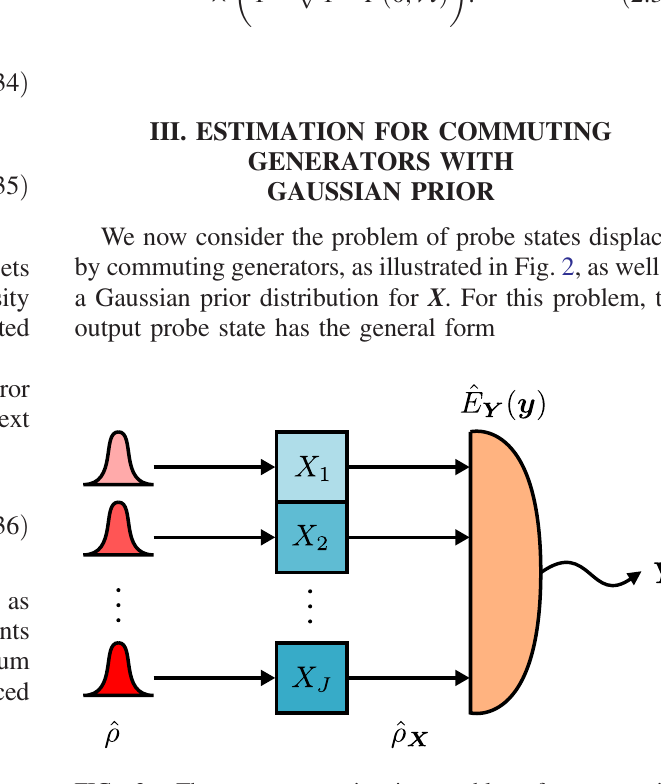
FIG. 2. The quantum estimation problem for commuting generators. The initial state ρ may be entangled, and each subsystem or mode undergoes a displacement X generated by j 0 . The output may be measured via ; ˆ g operator ˆ g , with ½ ˆ g j j k (cid:2) ¼ ˆ E y Þ some general joint measurement Y ð